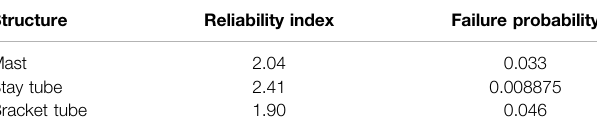
TABLE 5 | Reliability index of every part.